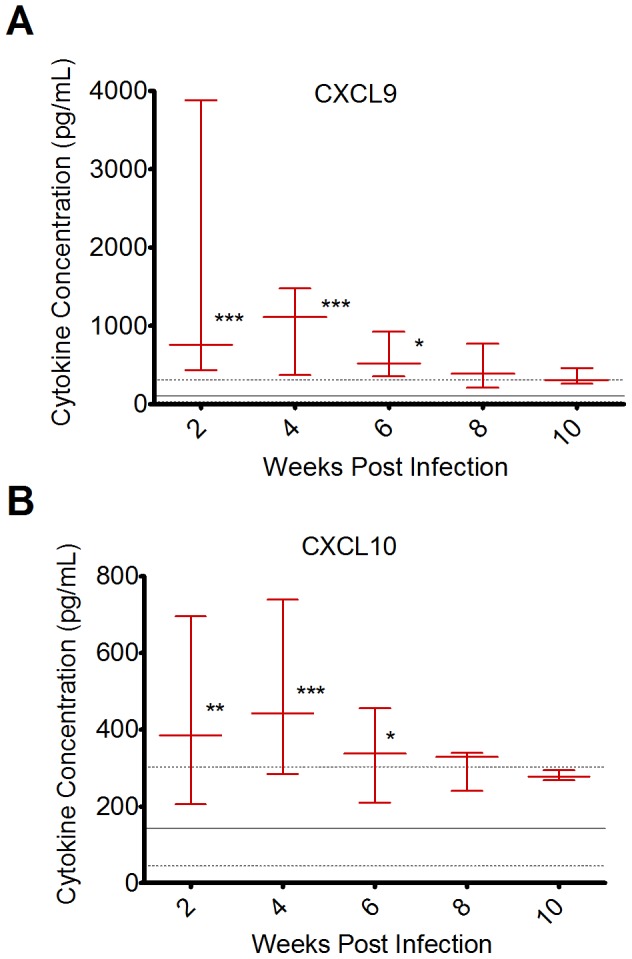
MHV68 causes systemic elevation of the chemoattractant chemokines CXCL9 and CXCL10.A) Quantification of CXCL9 in the plasma of MHV68-infected animals measured every 2 weeks for 10 weeks after infection. B) Quantification of CXCL10 in the plasma of MHV68-infected animals measured every 2 weeks for 10 weeks after infection. For both (A) and (B) red lines and error bars indicate medians and ranges, respectively, for MHV68-infected animals. Non-infected animals are represented by solid gray lines (medians) and dashed gray lines (ranges). Each point represents 3-7 mice with 1-3 technical replicates each. Levels for MHV68-infected animals at each timepoint were compared to non-infected animals using the non-parametric Kruskal-Wallis test with Dunn’s multiple comparison test. *p<.05, **p<.01, ***p<.001.